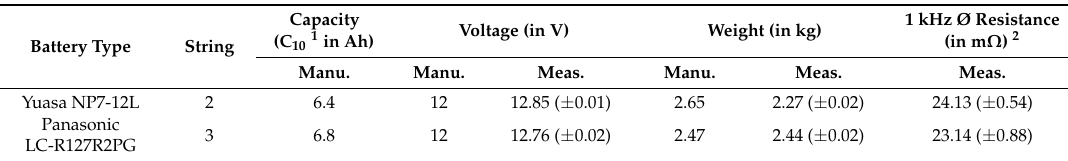
Table 1. Key parameters of the used batteries given by the manufacturer (Manu.) and measured values during inventory with an unknown SoC (Meas.). Values in brackets are the standard